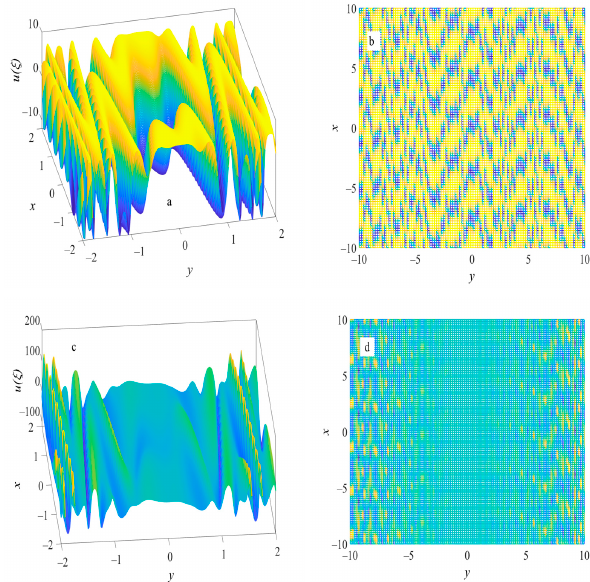
Figure 8. ( a ) Three-dimensional and ( b ) two-dimensional contour plots represent the spiral wave structure of Equation (35) and ( c ) three-dimensional and ( d ) two-dimensional contour plots represent the spiral wave structure of Equation (36) when 𝑘 = 2, 𝑚 = 1, 𝜆 = 1,𝑡 = 1 and 𝜔 = 14 .